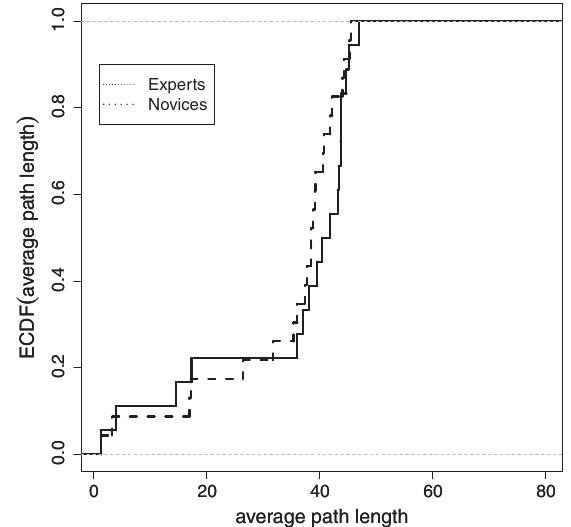
FIG. 7. Average path length. This is the distribution of the average path length for experts and novices. A Kolmogorov- Smirnov test suggests that experts and novices are not distin- guishable based on their average path length distributions ( p ¼ 0 : 3906